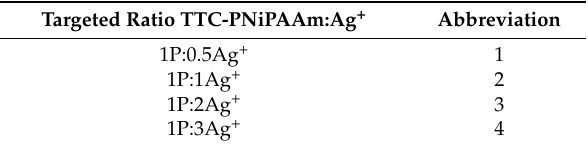
Table 1. Ratio targeted between TTC-PNiPAAm and silver, and